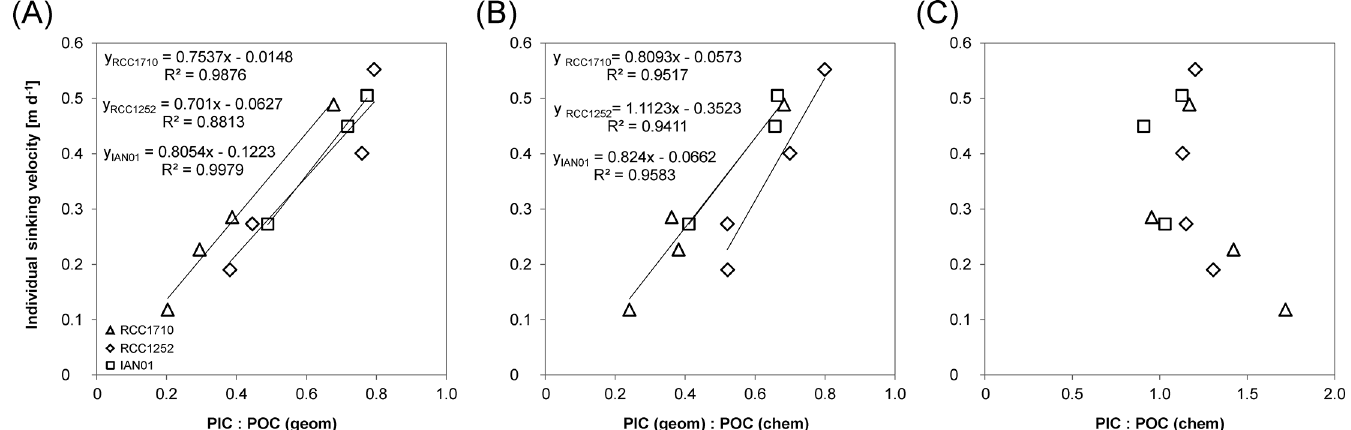
Fig 5. Individual sinking velocity relationship with the geometrically derived ratio between the particulate inorganic carbon and the particulate organic carbon (PIC: POC) (A), with the geometrically derived PIC and chemically derived POC (B), and with the chemically derived PIC: POC (C). PIC: POC in Figs A and B correspond to the individual cell ratio, while in Fig C the PIC of the ratio corresponds to the PIC in the attached plus the detached coccoliths, not only the attached as the PIC for the ratios in Figs A and B. Obtained for three different strains of E . huxleyi grown at different temperatures. Linear trend lines, corresponding equations, and r-squared values are shown in Figs A and B. The different symbols correspond to the three studied strains: strain RCC1710 (triangle symbols), strain RCC1252 (diamond symbols), and strain IAN01 (square symbols).